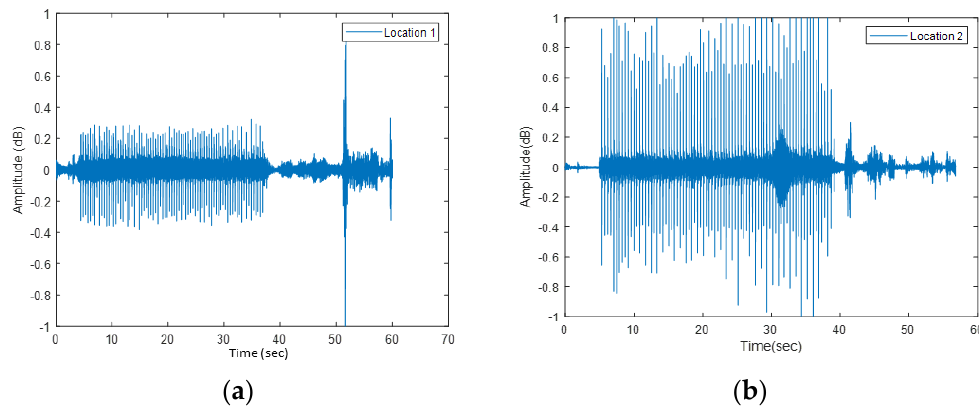
Figure 8. Time history of taps on: ( a ) Location 1; ( b ) Location 2.